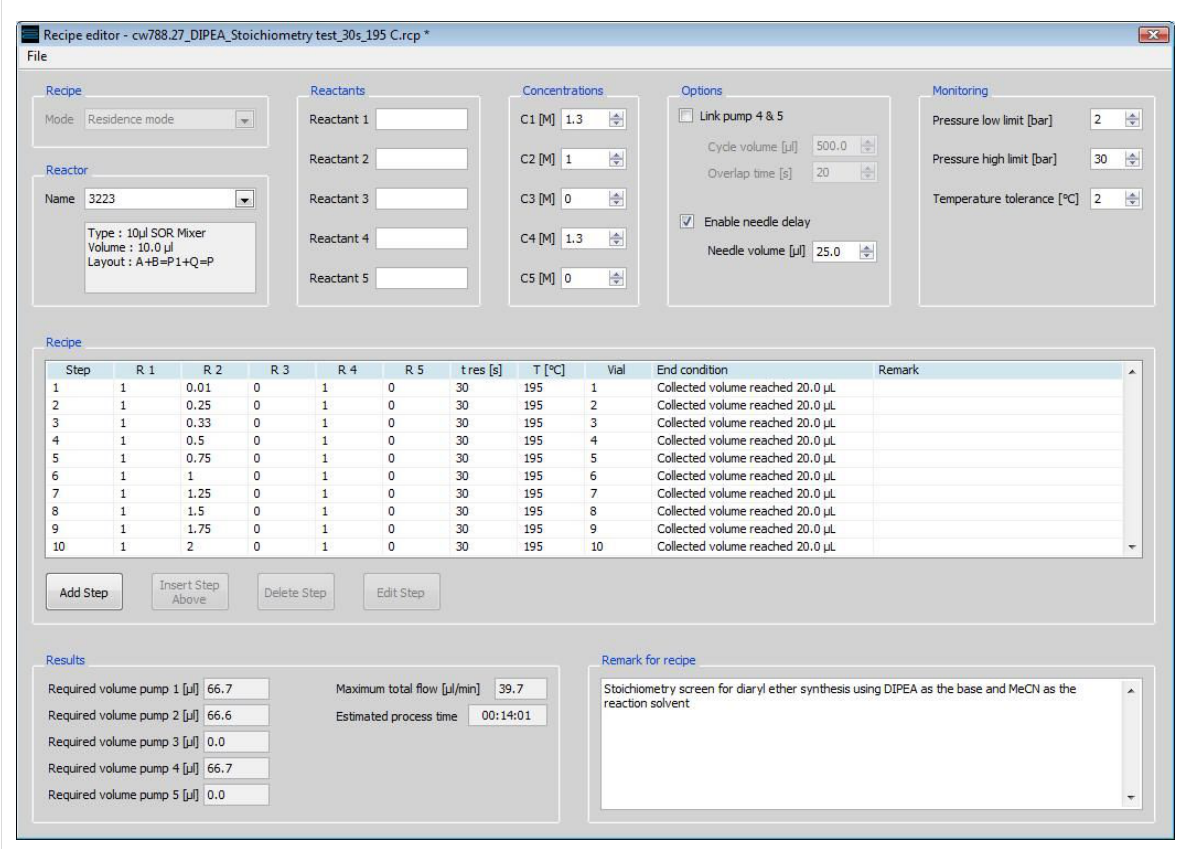
Figure 6: Screen shot from the Labtrix ® S1 control software illustrating the system file that enables the user to readily program a stoichiometry screen; this example varies the base stoichiometry at a fixed reaction time and temperature, however, the user can alter all 3 variables at any point.